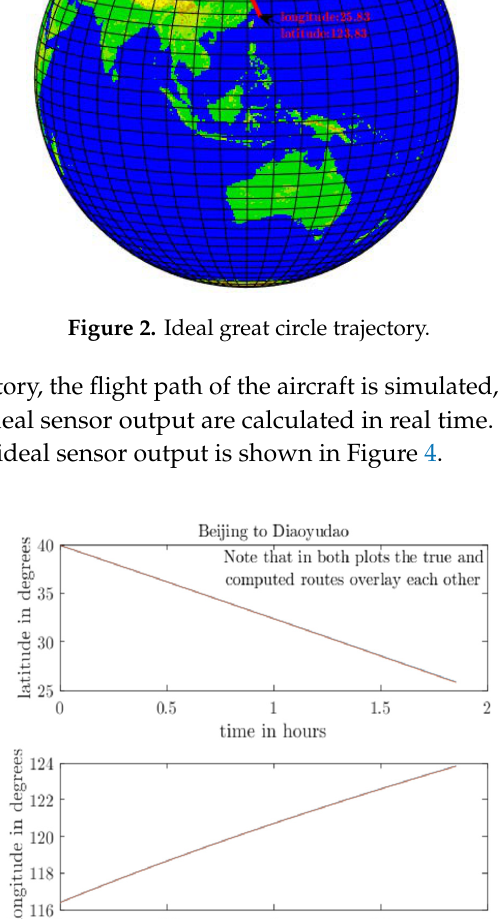
Figure 3. Coordinate variation during operation.